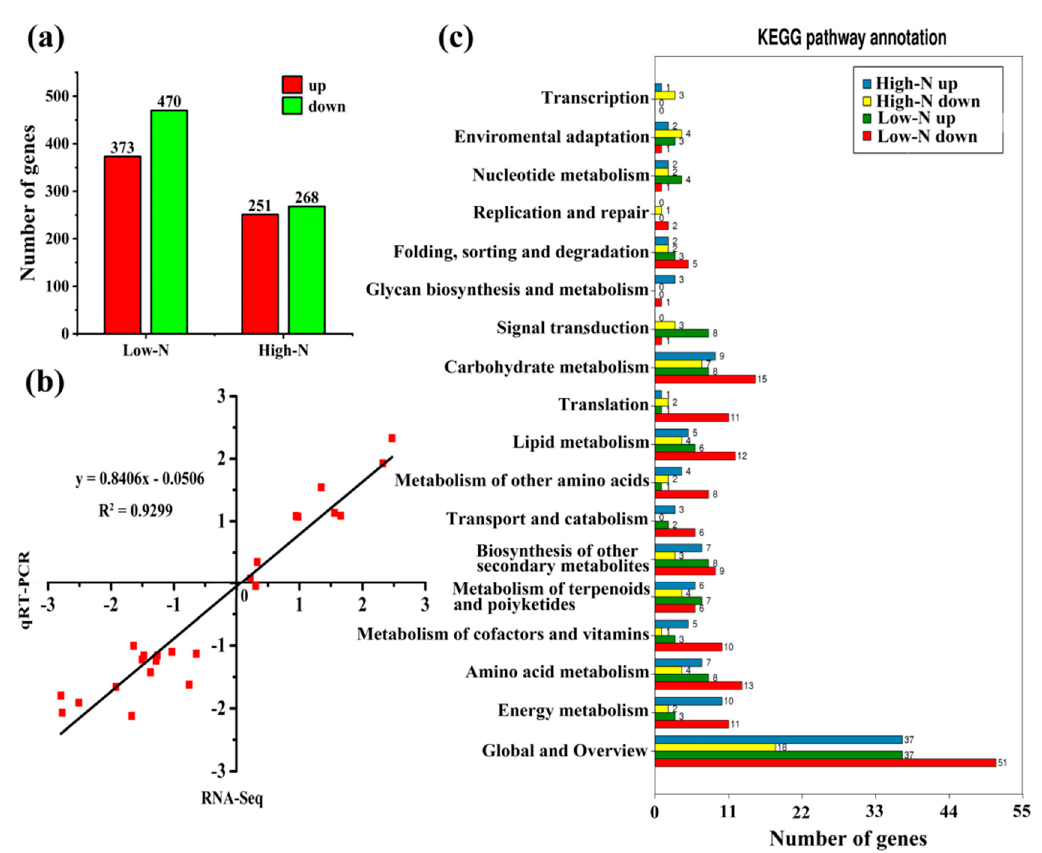
Figure 2. Transcriptional analysis of rice leaves under low nitrogen and high nitrogen: ( a ) The total number of differentially expressed genes (DEGs), upregulated and downregulated, under low nitrogen and high nitrogen; ( b ) a qRT-PCR assay was carried out for 12 randomly selected DEGs. Values are the log 2 (FC) (low N/control N or high N/control N) for genes. The correlation coefficient ( R 2 ) is indicated in the figure; and ( c ) KEGG analysis of